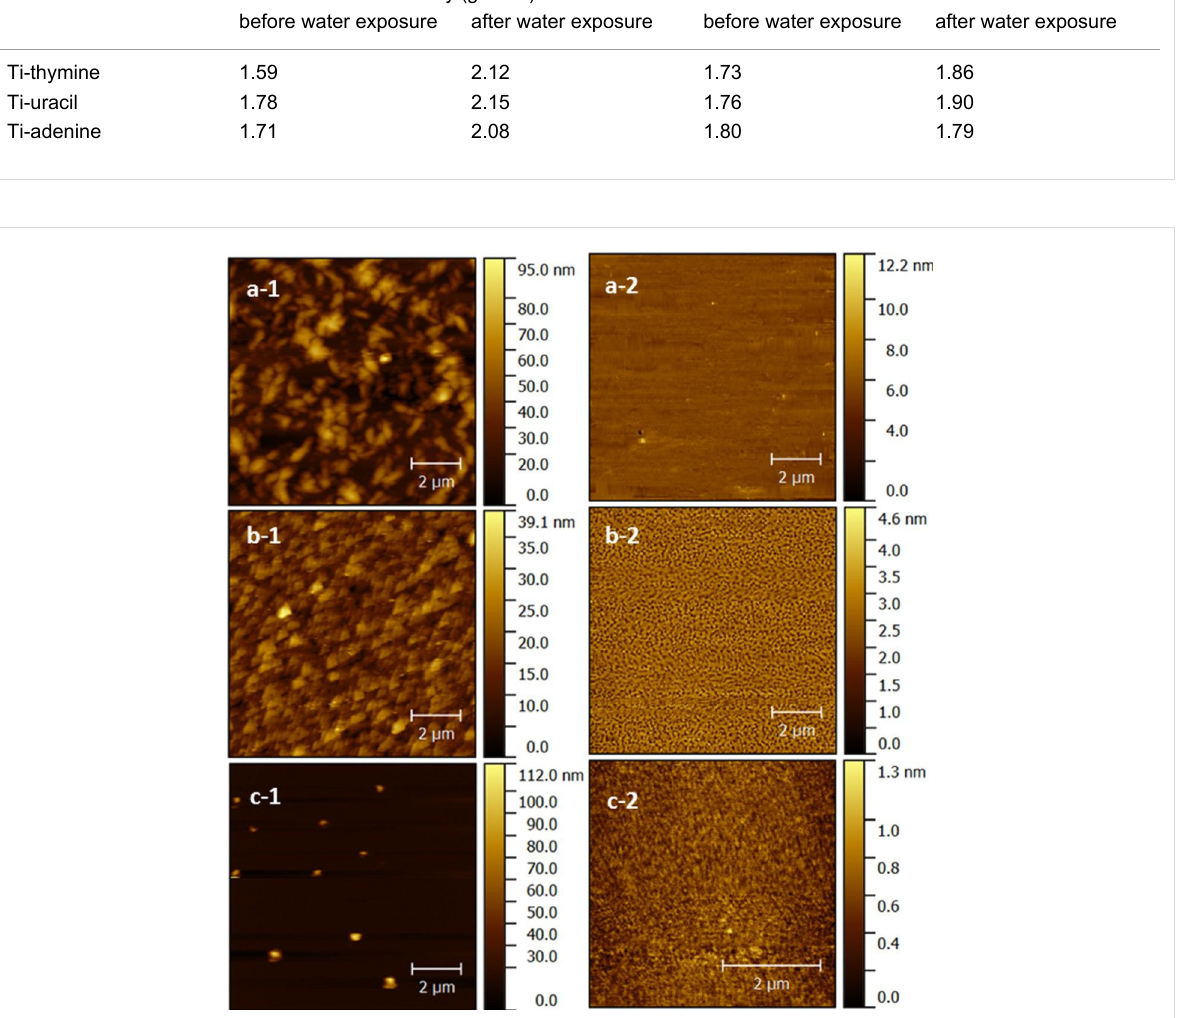
Figure 8: Surface topography as measured by AFM for films deposited using TTIP and (a-1) thymine (at 250 °C, 41 nm), (b-1) uracil (at 225 °C, 56 nm), (c-1) adenine (at 250 °C, 80 nm) and after water treatment (a-2) Ti-thymine (at 250 °C, 15 nm), (b-2) Ti-uracil (at 225 °C, 19 nm), (c-2) Ti-adenine (at 250 °C, 31 nm).